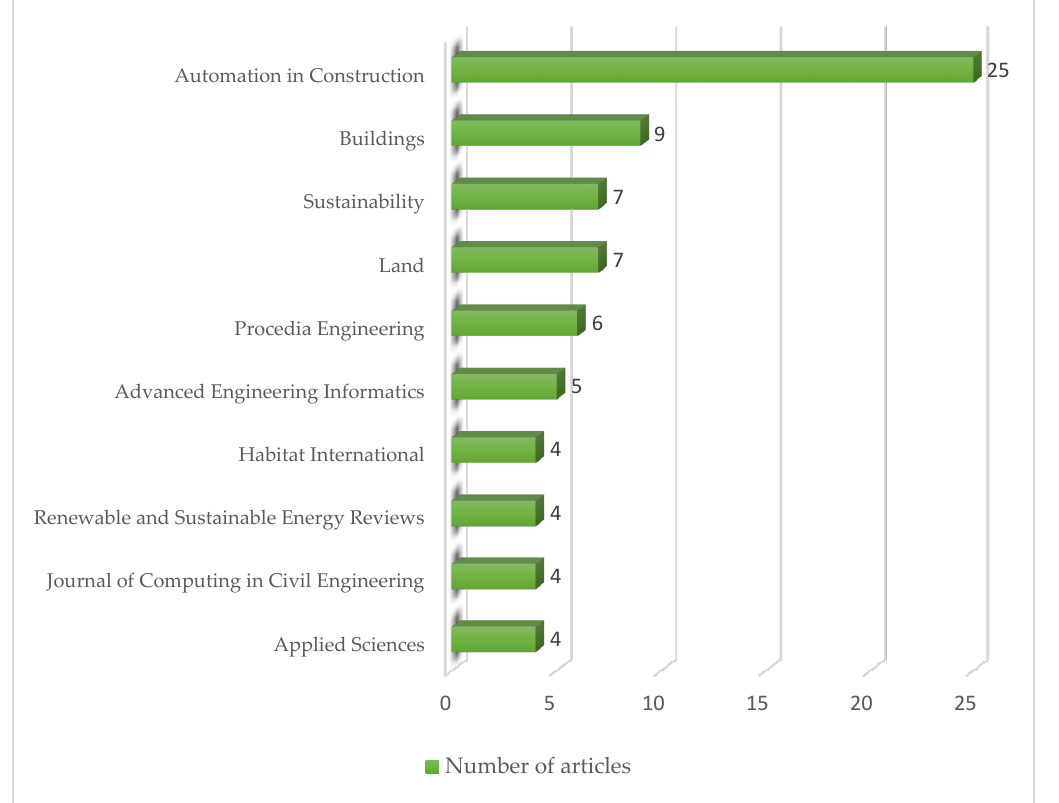
Figure 4. The number of reviewed articles included in the journals or conferences.